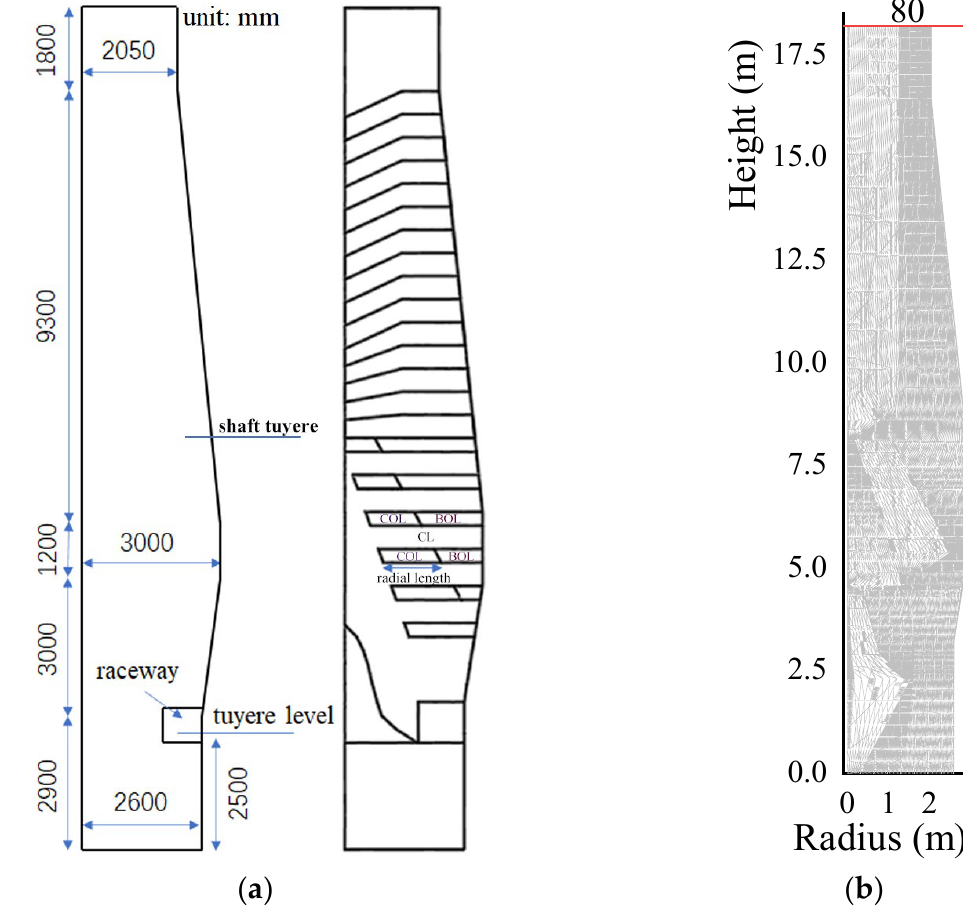
shown in Figure 3. The number of grid nodes is 820 × 80 = 65,600.